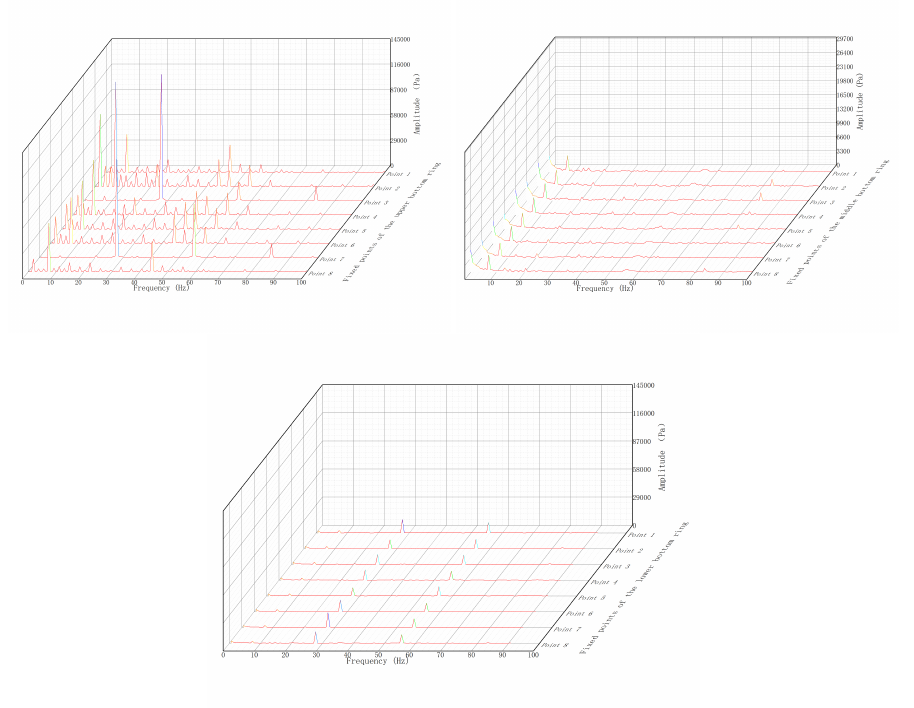
Figure 28. The pressure fluctuations of the upper, middle, and lower bottom ring